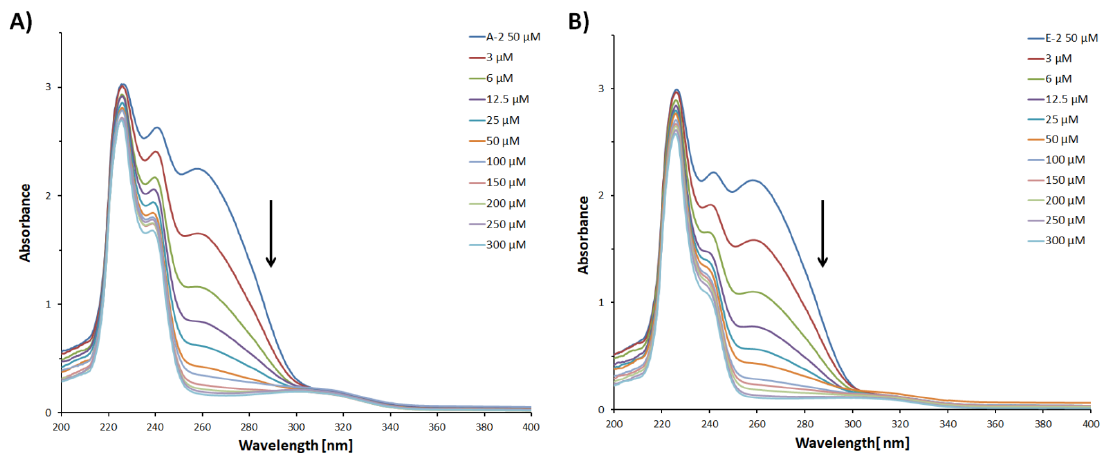
Figure 9. UV-Vis titrations of compounds: ( A ) A-2 and ( B ) E-2 with